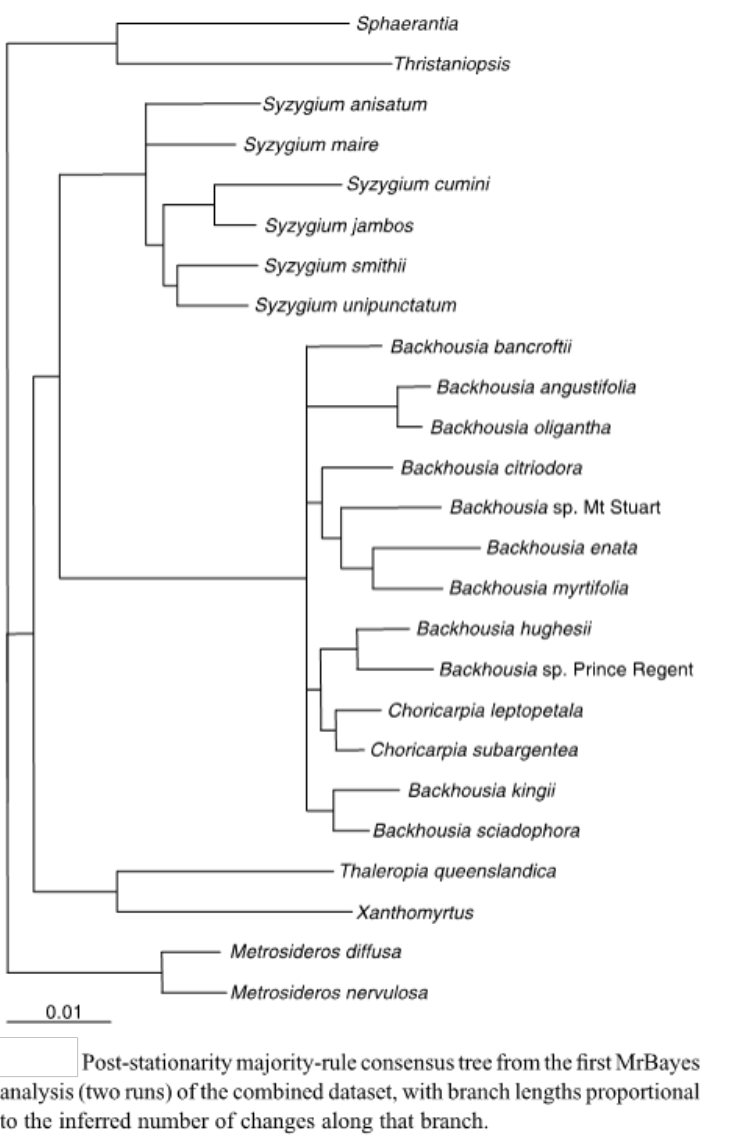
Figure 4. Dendrogram of Figure 2 from the 2012 paper by Harrington et al. [1]. Used with permission of Australian Systematic Botany